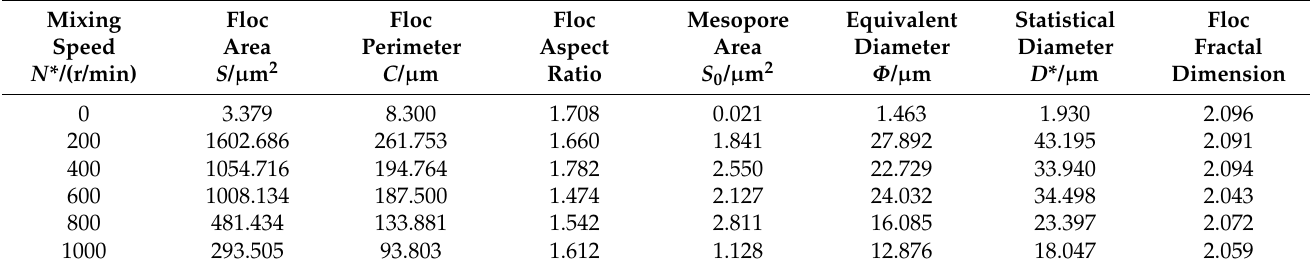
Table 10 is analyzed by Image-Pro-Plus 6.0 software and (Formulas (15)–(17)), which shows that when the mixing speed is 400 r/min, the equivalent diameter of − 0.045 mm slime settling floc is the largest, and the settling speed of slime floc is the fastest on the microscopic level. Figure 11a is the analysis diagram of floc area of − 0.045 mm slime at the mixing speed of 0–1000 r/min. Figure 11b shows the fractal dimension fitting diagram, when the mixing speed is 0–1000 r/min, the mean fractal dimension of − 0.045 mm coal slime floc is